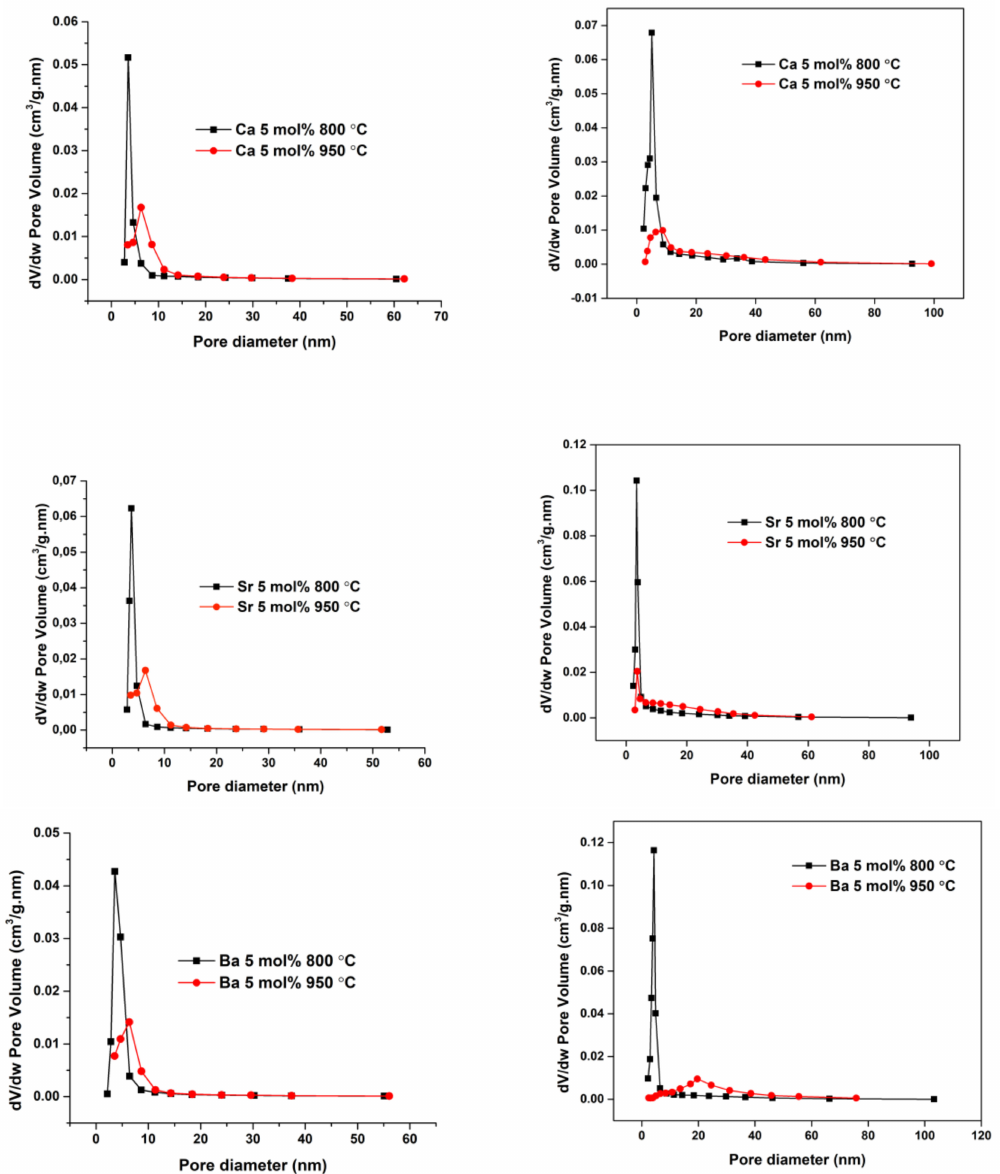
Figure 15. The pore size distribution of mixed metal oxides (MMO) obtained by heating the Mg 1.95 Ca 0.05 / Al 1 precursor gels ( top, left ), by heating the Mg 1.95 Ca 0.05 / Al 1 LDHs ( top, right ), by heating the Mg 1.95 Sr 0.05 / Al 1 precursor gels ( middle, left ), by heating the Mg 1.95 Sr 0.05 / Al 1 LDHs ( middle, right ), by heating the Mg 1.95 Ba 0.05 / Al 1 precursor gels ( bottom, left ), and by heating the Mg 1.95 Ba 0.05 / Al 1 LDHs ( bottom, right ) at 800 ◦ C and 950 ◦